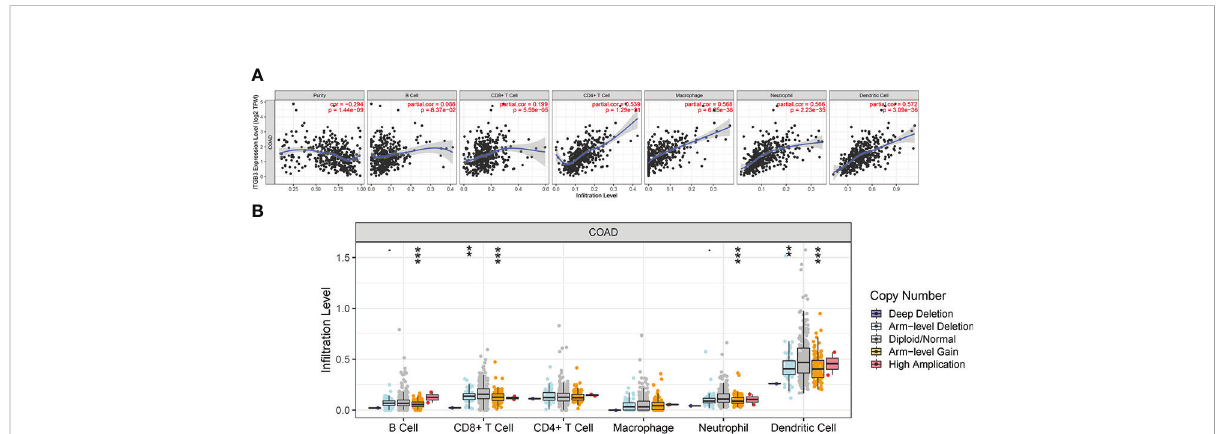
FIGURE 4 Correlations of ITG b 3 expression with immune in fi ltration level in COAD. (A) ITG b 3 expression signi fi cantly related to tumor purity and to in fi ltrating levels of CD8+ T cells, CD4+ T cells, macrophages, neutrophils, and dendritic cells in COAD. (B) ITG b 3 CNV affecting the in fi ltrating levels of CD8+ T cells, B cells, neutrophils, and dendritic cells in COAD. *, p < 0.05, **, p < 0.01, ***, p <